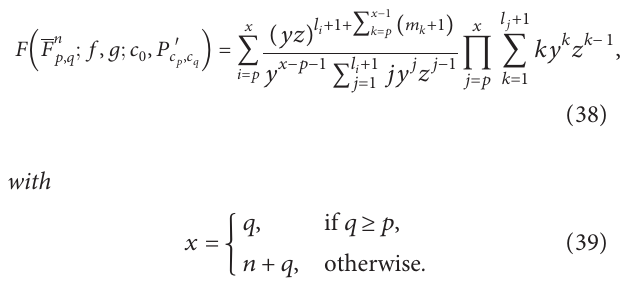
Table 2: The subtree number index STN ( F